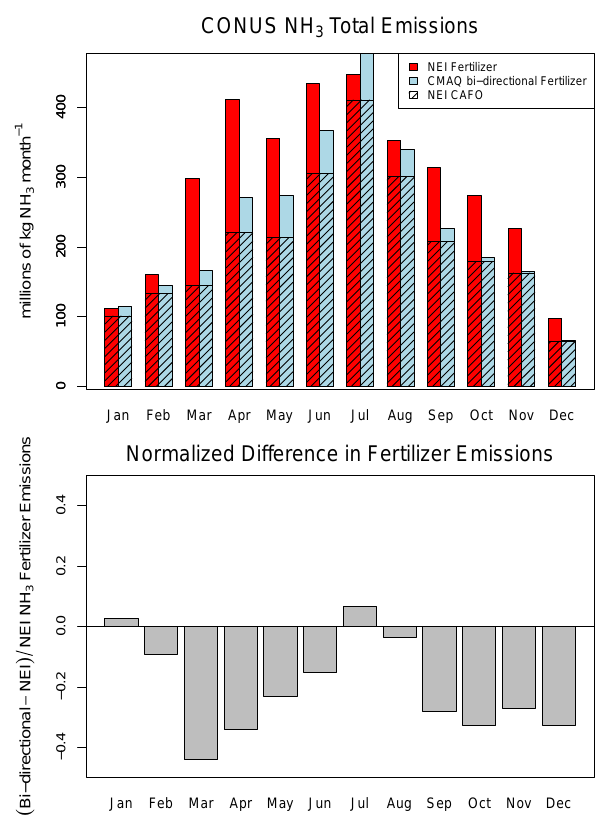
Fig. 1. Total domain wide NH 3 emissions estimated by the NEI and CMAQ with bidirectional exchange coupled to the EPIC agroe- cosystem model (top panel) and the fractional difference in the NH 3 fertilizer emissions (bottom panel) on the CONUS domain from the NEI estimated in CMAQ 5.0 with bidirectional